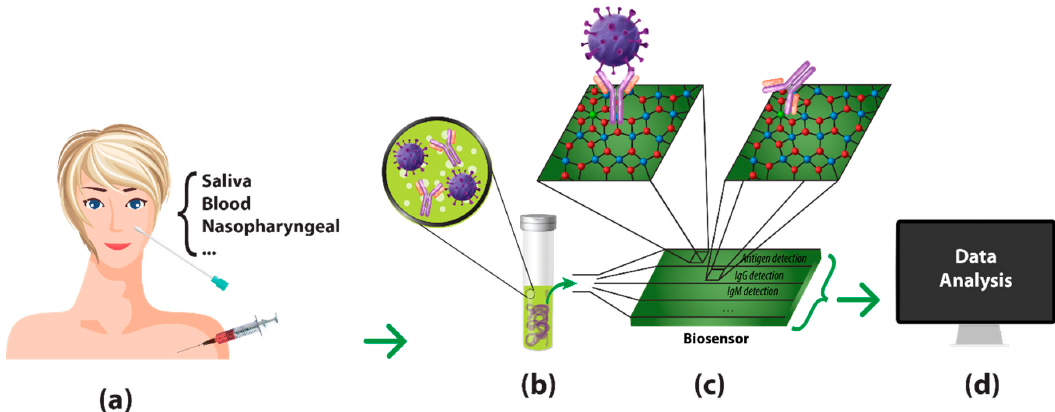
Figure 9. The schematic representation of the process for pathogen detection in samples from humans. ( a ) Sample is derived from the patient’s blood or other body fluids. ( b ) The schematic representation of the presence and immobilization of different biomarkers in the sample taken from the patient. ( c ) The specific bindings of different analytes to the sensor take place by using a multichannel transducer; a separate channel for each biomarker. ( d ) The response from the transducer is then transferred to the detector where the data are amplified and analyzed.